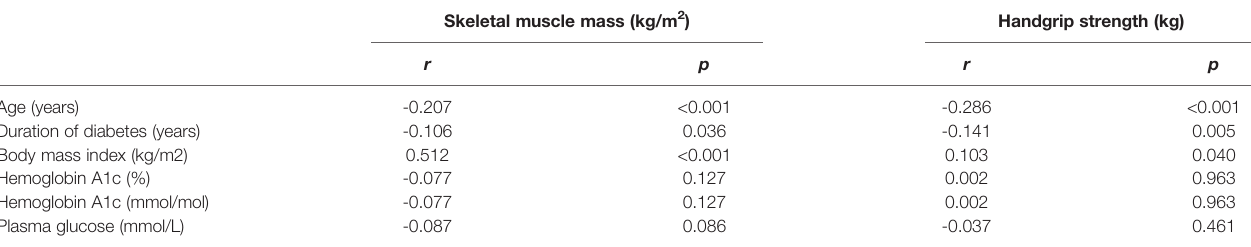
TABLE 2 | The correlation between the variables of diabetes and skeletal muscle mass or handgrip